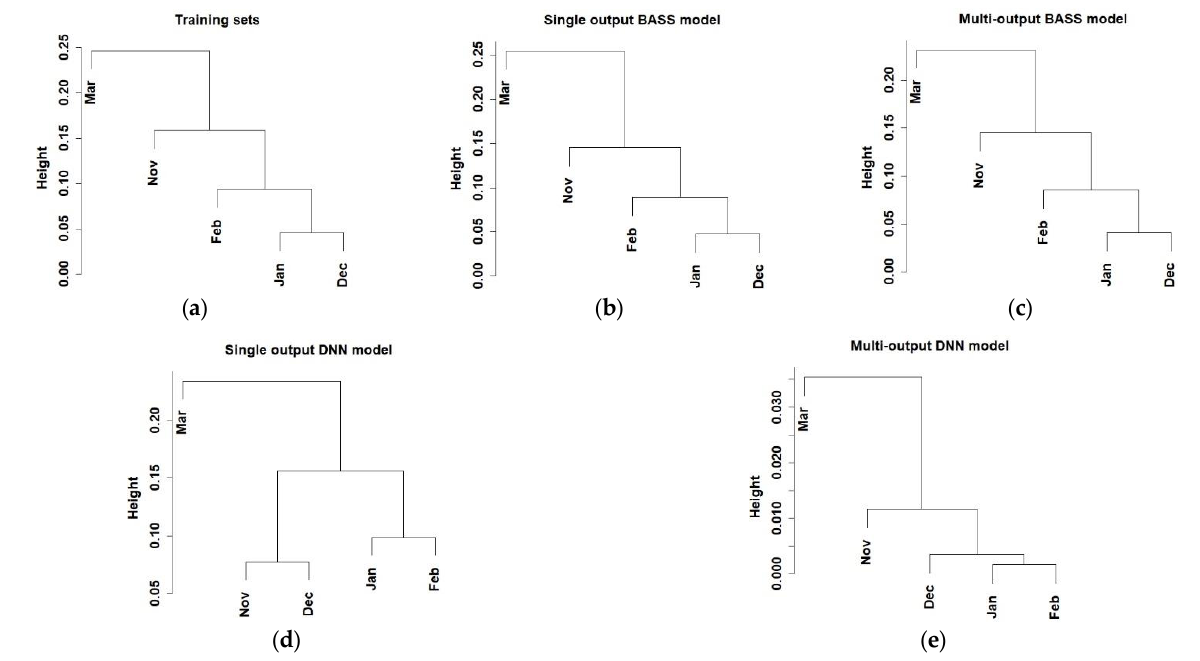
Figure 17. Dendrogram of monthly heating energy for the training set and four machine learning models.